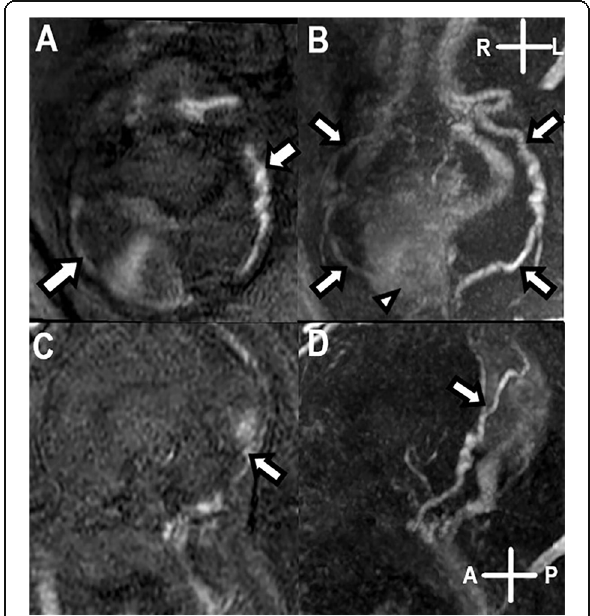
Fig. 2 Fetal MRI at 28 weeks 4 days — 3D gradient recalled echo Dixon- based intracranial MRA images: A , B Coronal thin and MIP images show prominent bilateral occipital arteries (arrows) supplying the DSM, which is also seen in the arterial phase being a venous structure (arrowhead). C , D Sagittal thin and MIP images show the left occipital artery supplying the DSM. These represent the arterial feeders to the